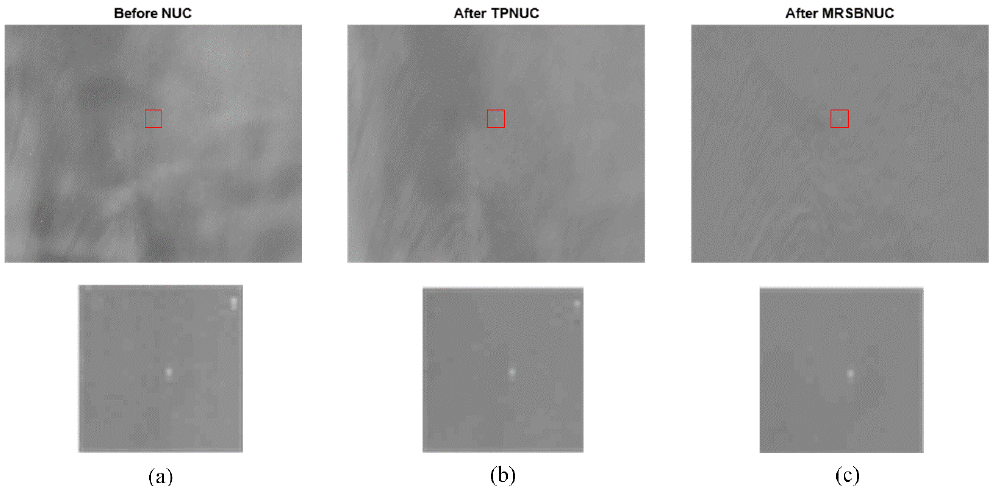
Figure 17. Target 1 : ( a ) before NUC, ( b ) after TPNUC and ( c ) after MRSBNUC.